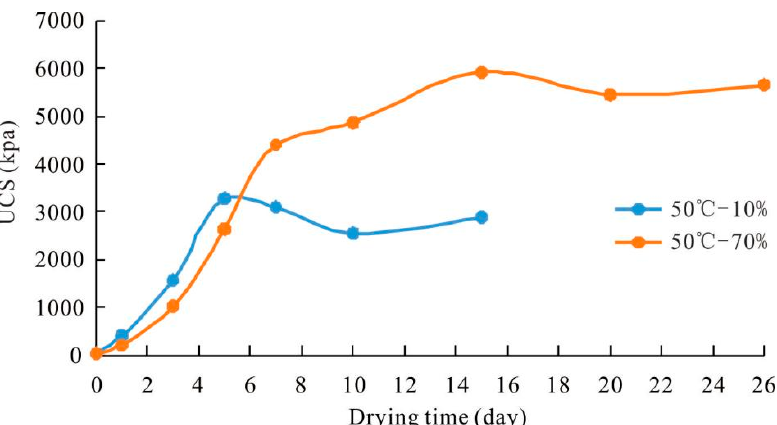
Figure 10. The compression strength of expansive soil varies with the duration of dehydration under different conditions. different